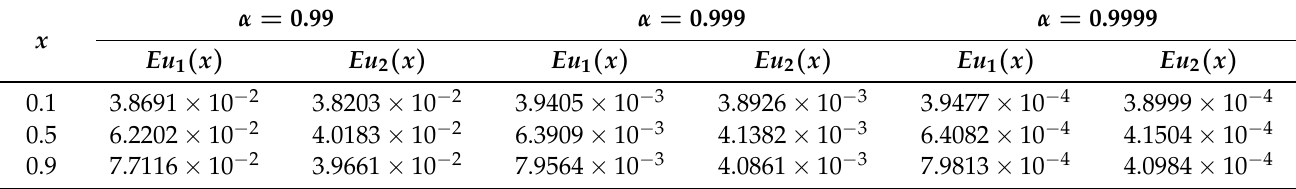
Table 2. Absolute errors of u 1 ( x ) and u 2 ( x ) at different orders α for Example 1. α = x